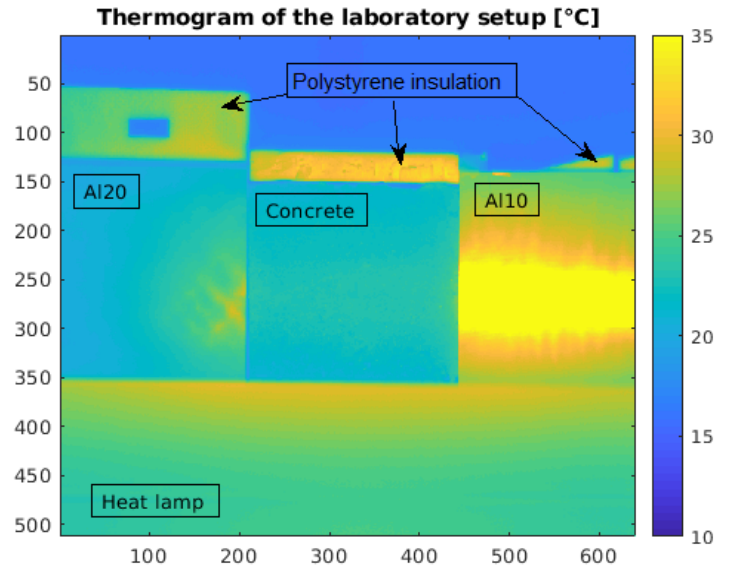
Figure 2. Overview of the laboratory setup. Note the polystyrene insulation in the back of each sample to ensure the backside only experiences minor heat loss.